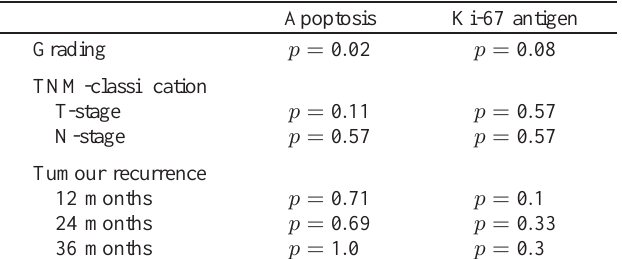
Table 1 Statistical analysis of the correlation between apoptosis and cell